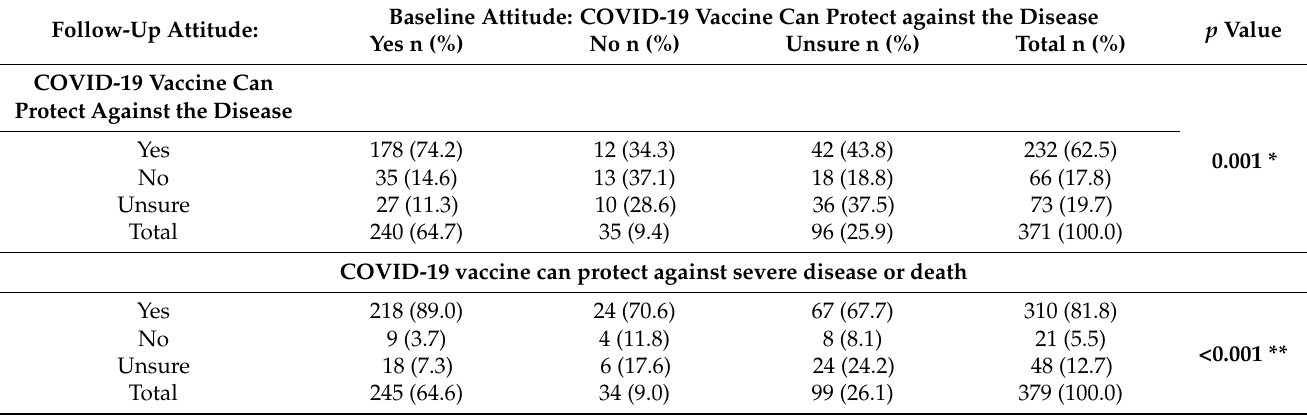
Table 2. Change of attitude regarding COVID-19 vaccine protection.